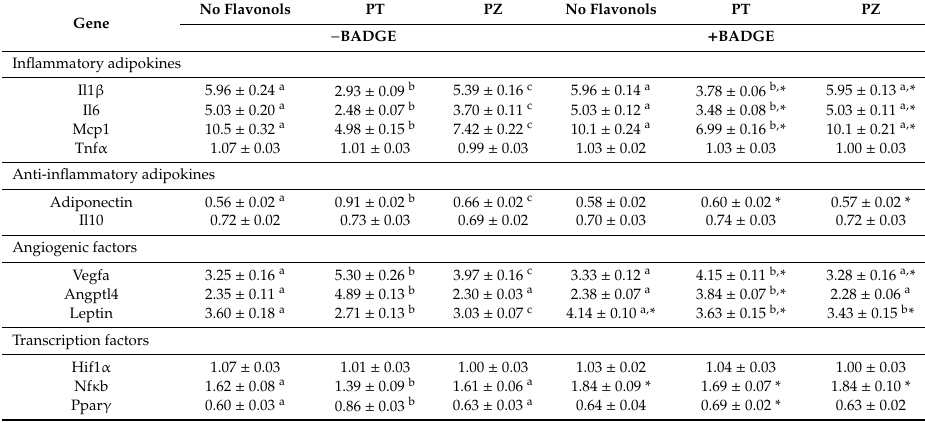
Table 2. mRNA expression in CoCl 2 -stimulated adipocytes treated with PT or PZ, with and without BADGE 1